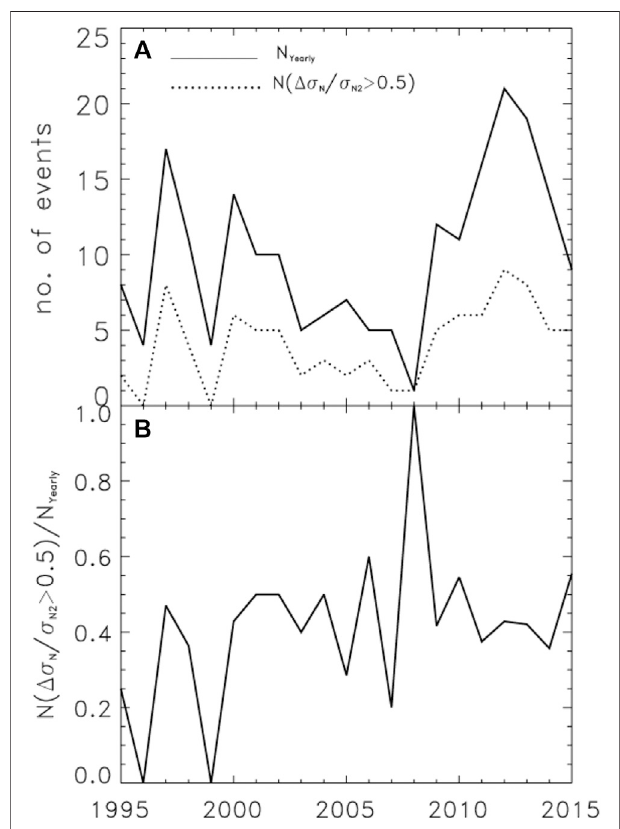
FIGURE 5 | (A) Yearly occurrence frequency of all MC events, N Yearly (solid-lines), and MC events with Δ σ N / σ N2 ≥ 0.5, N Δ σ N/ σ N2 ≥ 0.5 (dotted line). (B) Normalized yearly N Δ σ N/ σ N2 ≥ 0.5 with N Yearly